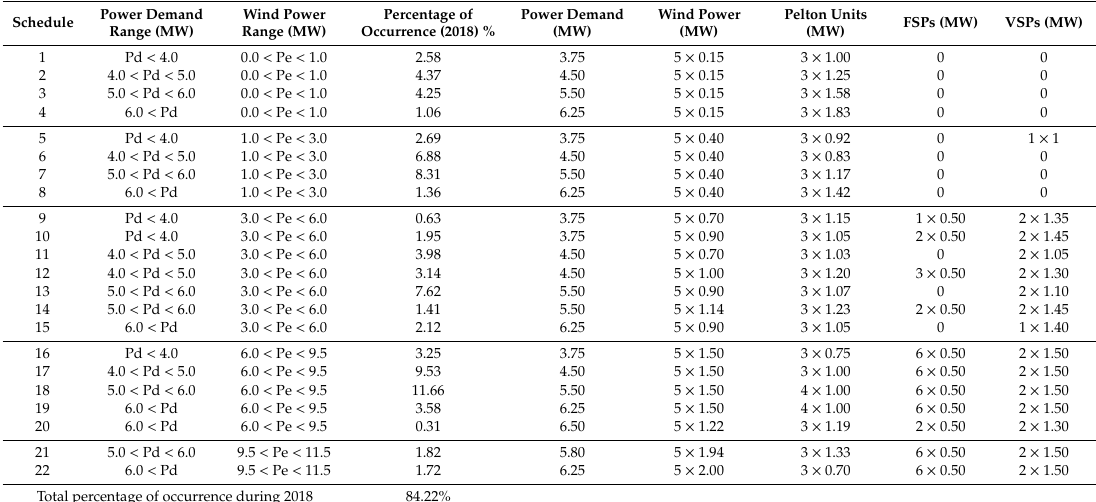
Table 2. Twenty-two generated schedules and its associated percentage of occurrence during 2018.